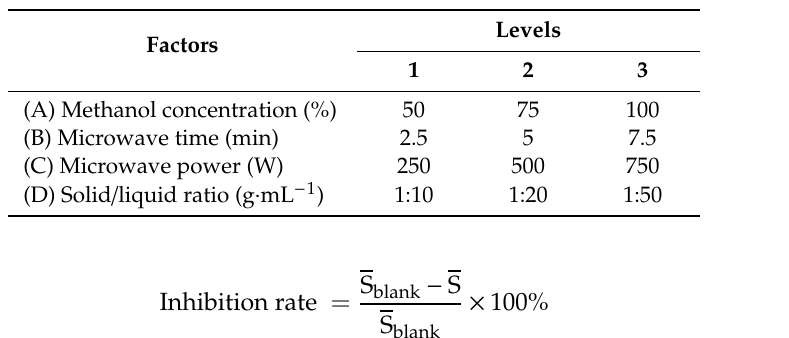
Table 1. Factors and levels of orthogonal test.